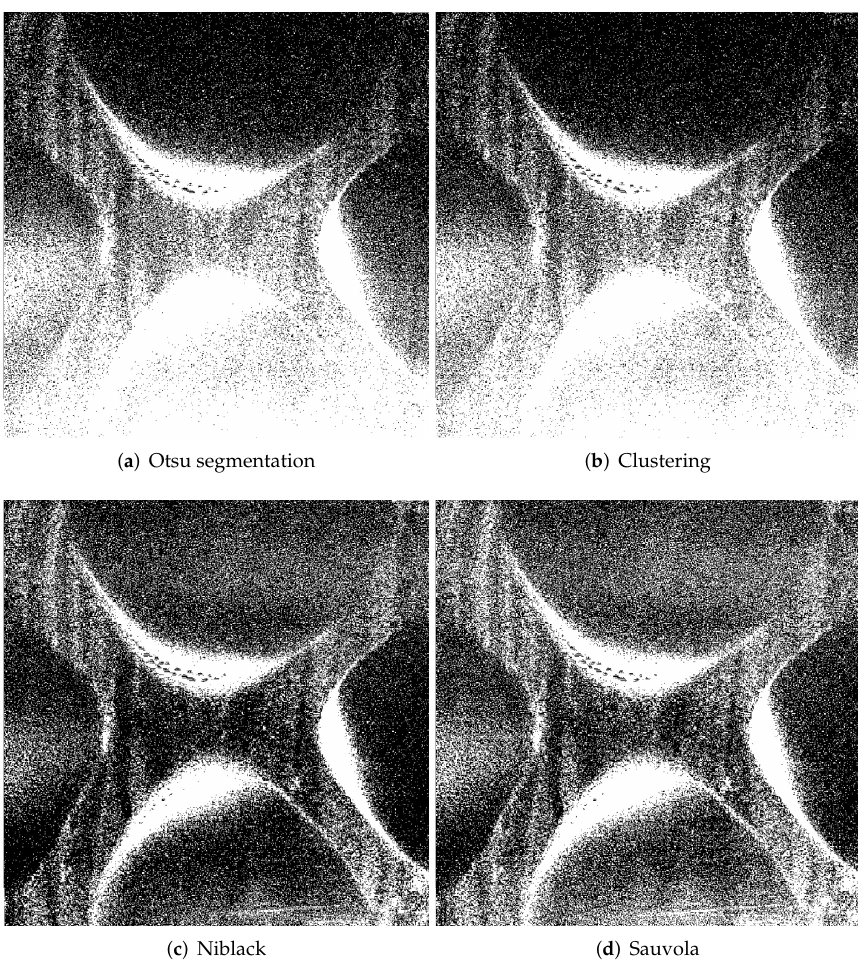
Figure 13. Results for different segmentation